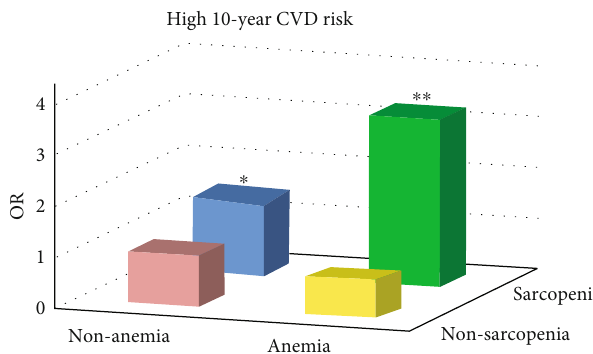
Figure 3: Multivariate adjusted ORs of the high 10-year CVD risk in patients with type 2 diabetes classi fi ed according to whether or not having sarcopenia or anemia. Note: logistic regression model adjusted for age, diabetes duration, diabetic complications, body mass index, HbA1c, total cholesterol, triglyceride, low-density lipoprotein cholesterol, albumin, creatinine, and smoking status. ∗ P < 0 : 05 vs. patients in the nonsarcopenia and nonanemia group by the Cox regression analysis ( OR = 1 : 462 , 95% CI 1.085 – 1.972). ∗∗ P < 0 : 001 vs. patients in the nonsarcopenia and nonanemia group by the Cox regression analysis ( OR = 3 : 283 , 95% CI 2.038 –